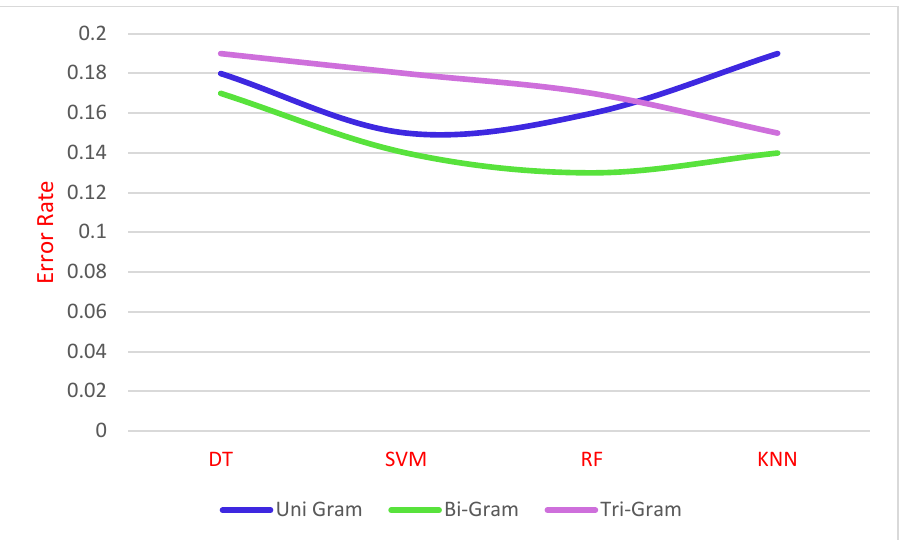
Figure 5. Error rate of the N-gram stack autoencoders.